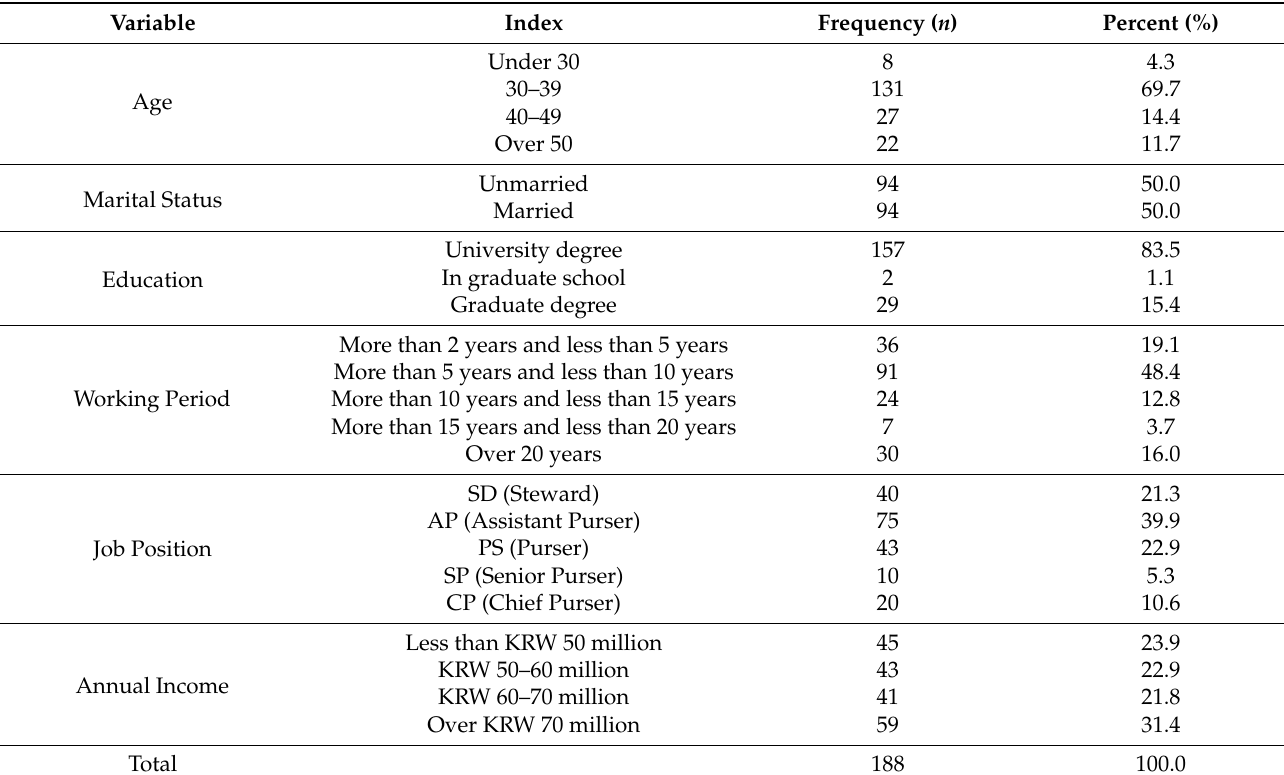
Table 1. Demographic characteristics of